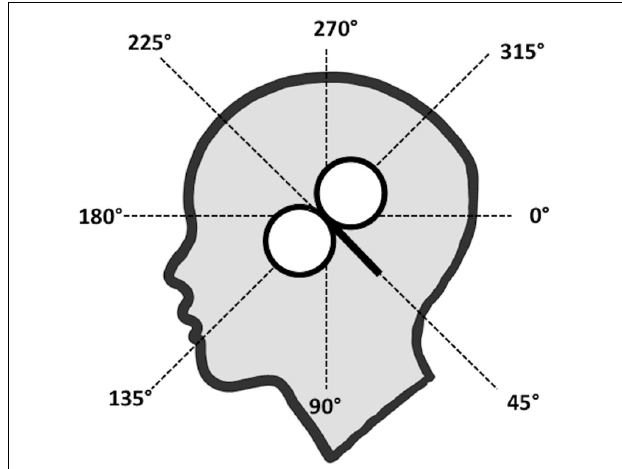
FIGURE 1 | Eight coil orientations used in the lip and hand conditions. The intersection of the lines was placed on the subject’s hot spot for lip or hand M1 and the coil handle was aimed toward the angle tested (here: 45 ◦